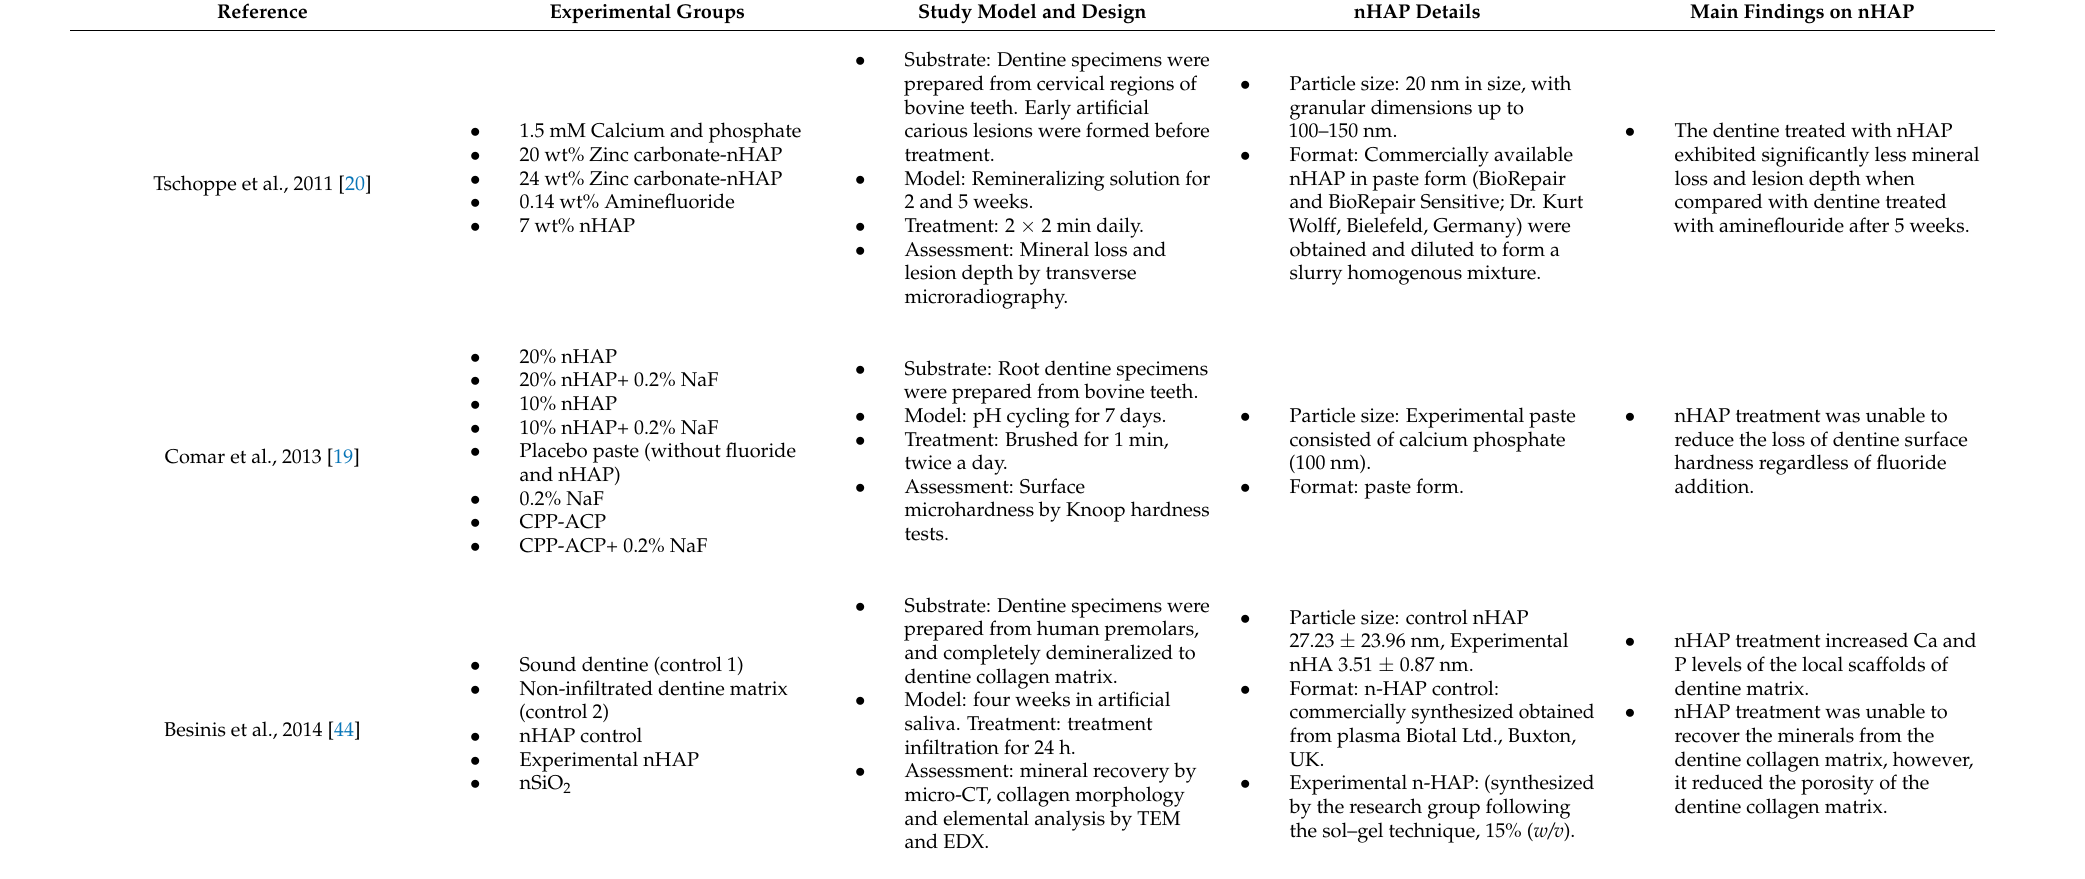
Table 2. Summary of the effect of hydroxyapatite nanoparticles on dentine/cementum